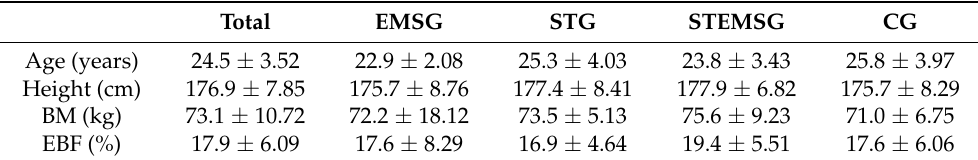
Table 1. Mean ± standard deviation of the subjects age, height, body mass (BM), and estimated body fat (EBF). Total EMSG STG STEMSG CG Age (years) 24.5 ± 3.52 22.9 ± 2.08 25.3 ± 4.03 23.8 ± 3.43 25.8 ± 3.97 Height (cm) 176.9 ± 7.85 175.7 ± 8.76 177.4 ± 8.41 177.9 ± 6.82 175.7 ± 8.29 BM (kg) 73.1 ± 10.72 72.2 ±